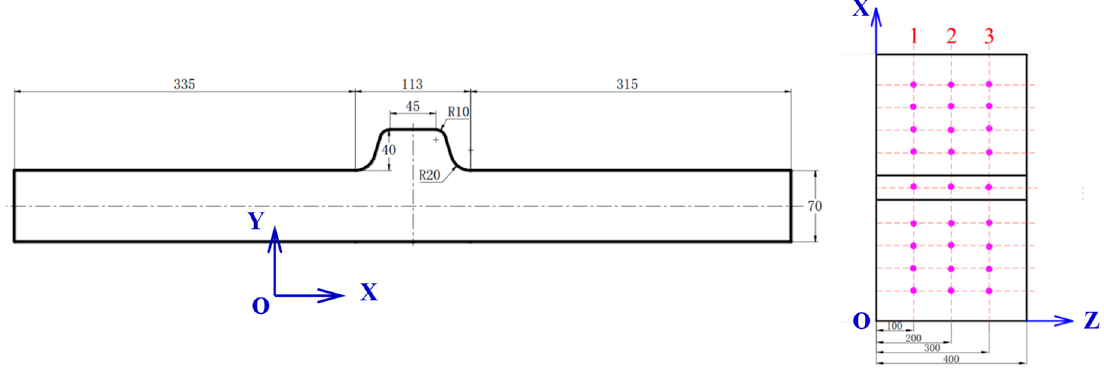
Figure 2. Dimensions of the T-type rib.